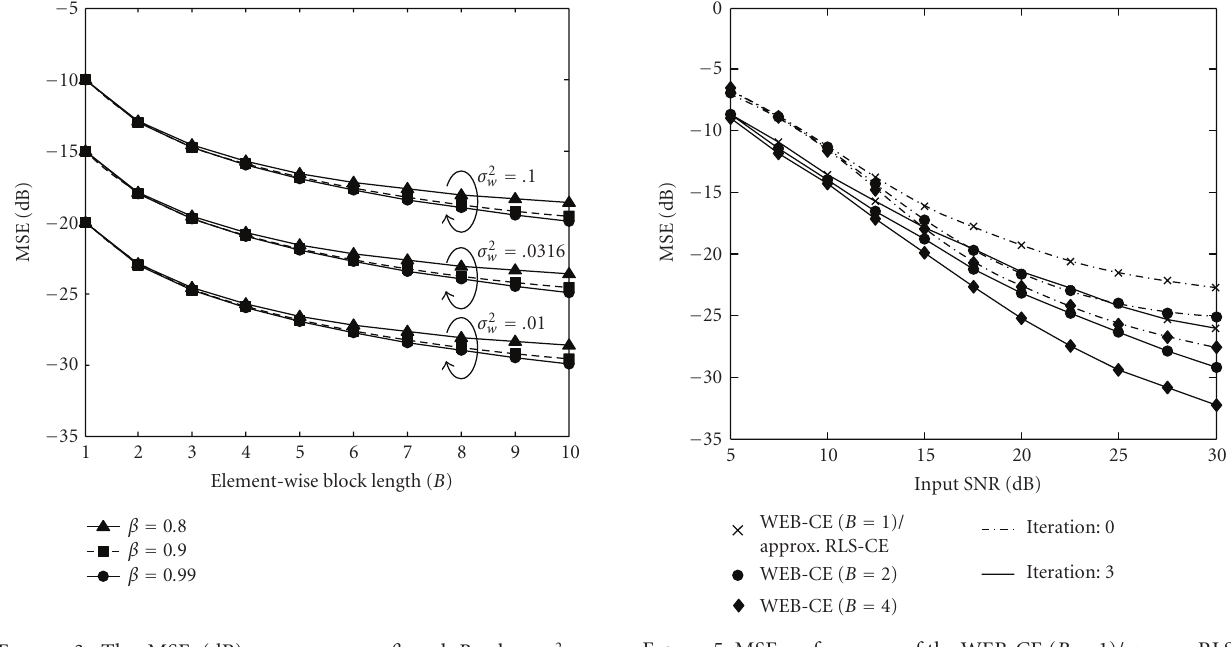
Figure 3: The MSE (dB) curves versus β and B when σ 2 0 . 1,0 . 0316 and 0.01.